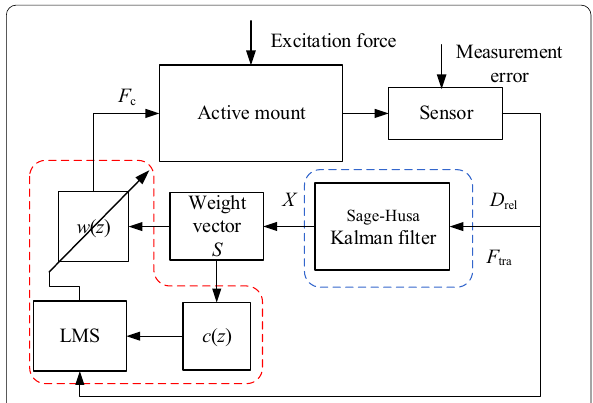
Figure 4 Control principle of the active mounting